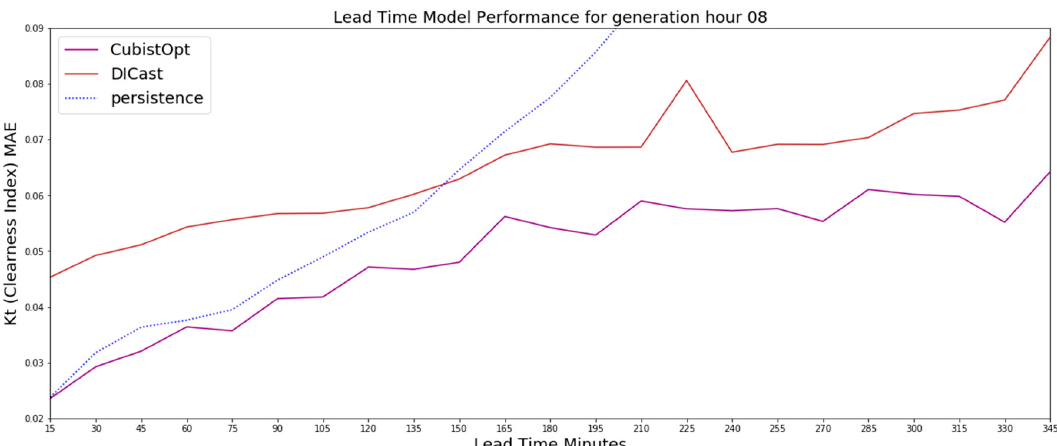
Figure 5. The 8 UTC generation time results on the test dataset for the CubistOpt method, the clearness index persistence and the DICast forecasts, which show that the CubistOpt (purple line) method has the lowest error over all time periods.